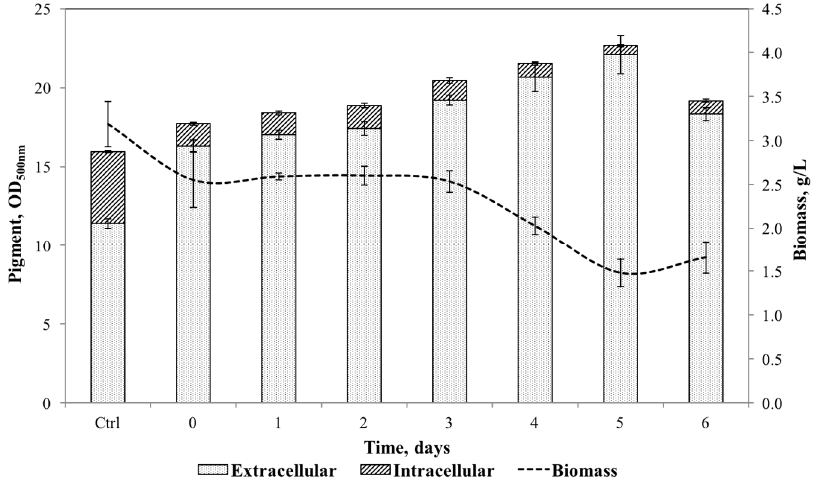
Figure 2. Effect of the addition time of Triton X-100 (35 g/L) on extracellular and intracellular pigment yield and biomass